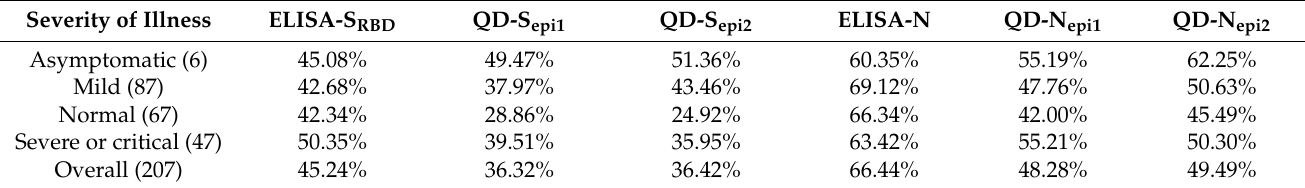
Table 1. Dispersion coefficient of data values from either QD-peptides or ELISA assay with the indicated